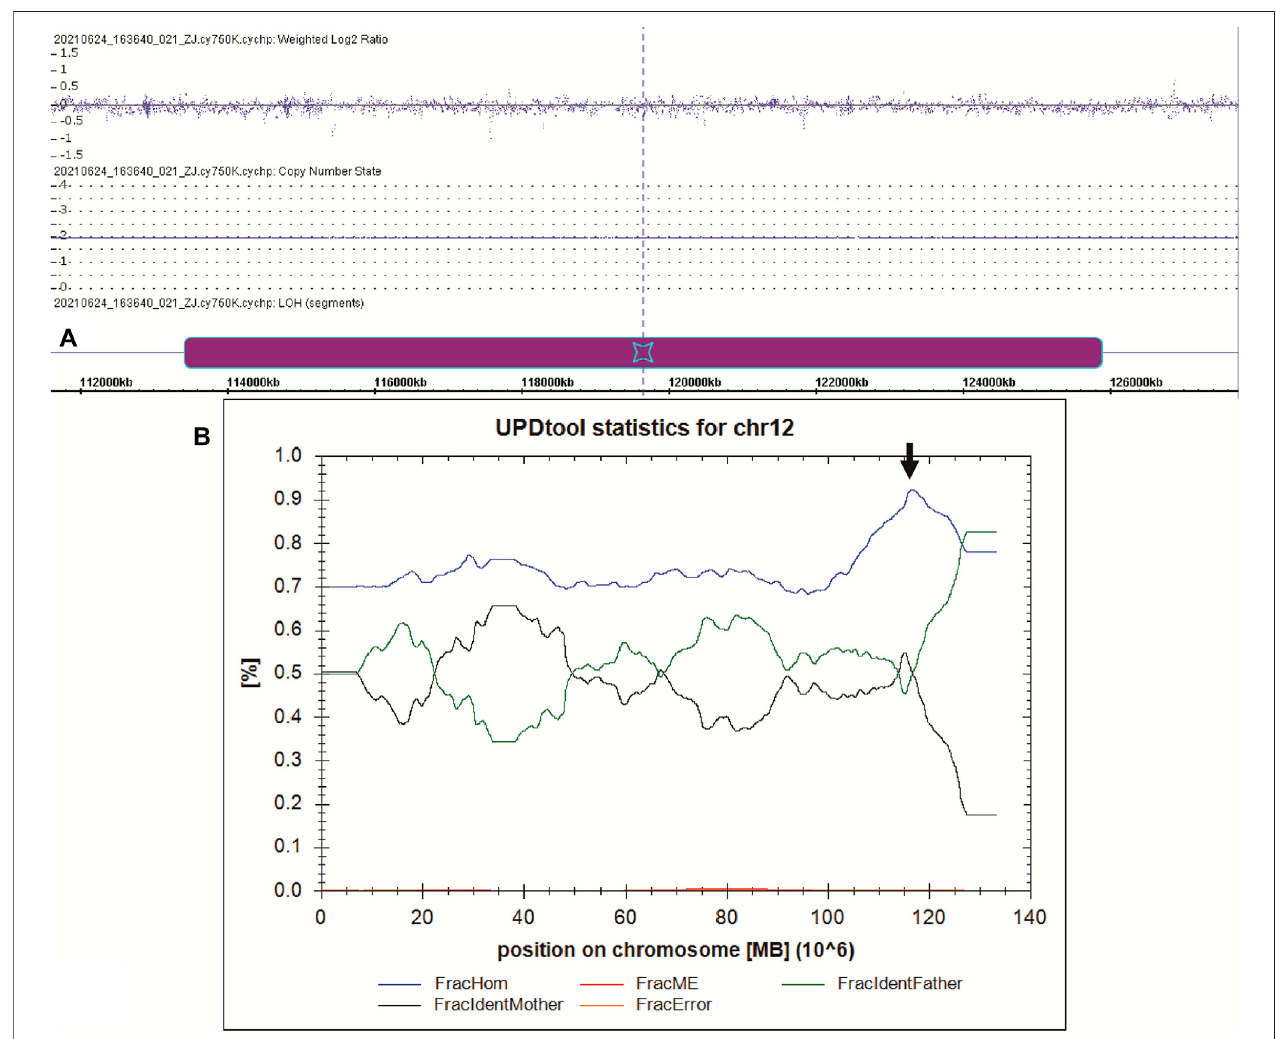
FIGURE 3 | UPD analysis of the manharboring a CFAP251 variant. (A) The SNP-array result of the patient. The purple box indicates the region of ROH on chromosome12. (B) TheresultsofUPDtoolfortheclassi fi cationofuniparentaldisomy(UPD).BluelineindicatesfractionofhomozygousSNPs;redlineindicatesfraction of mendelian error SNPs; green line indicates fraction of SNPs where the genotype is identical to the father; black line indicates fraction of SNPs where the genotype is identicaltothemother;yellowlineindicatesfractionoferrors( (cid:1) MEthatcannotbeexplainedbyUPD).Theblackarrowindicatestheregionofisodisomyfrom115to 125 MB of chromosome